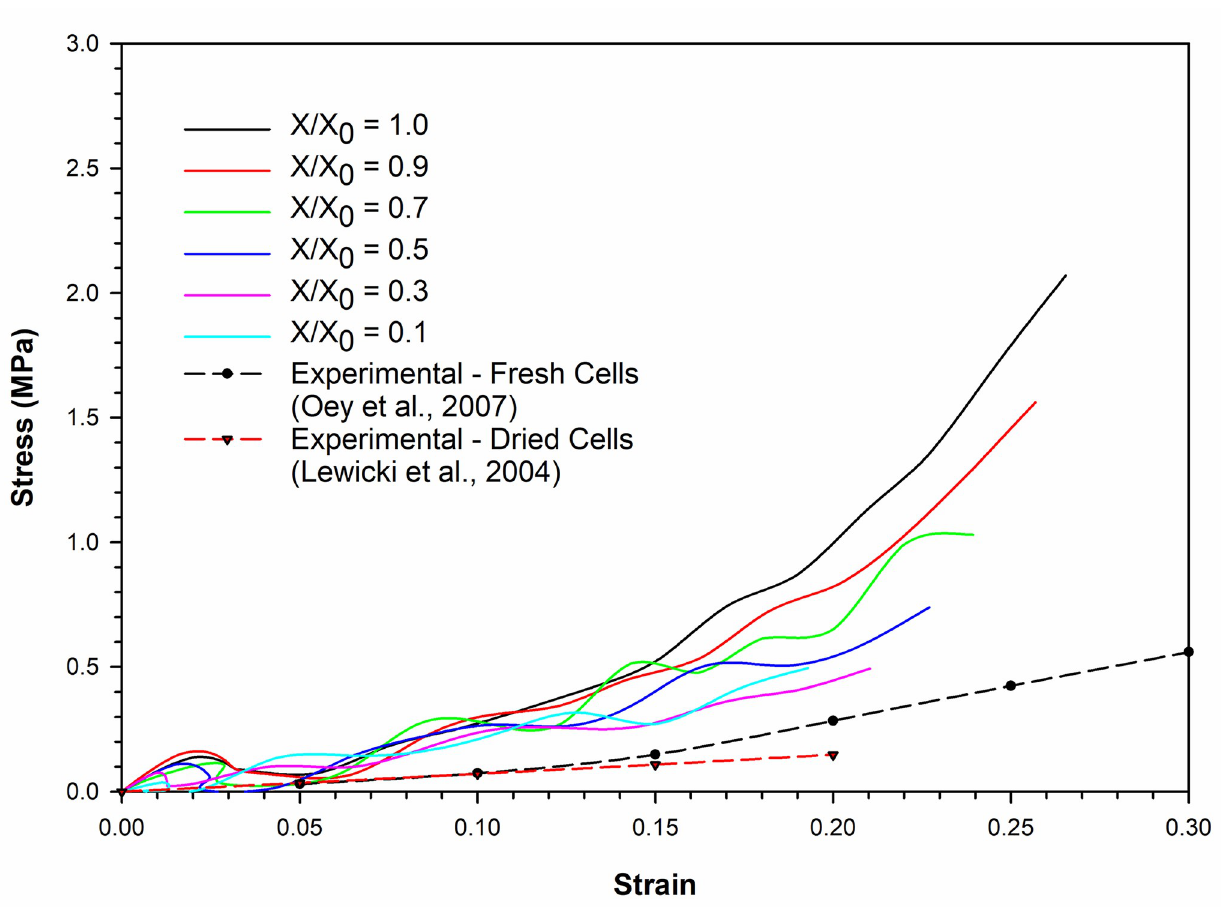
Fig 7. Comparison of model predictions for stress-strain relationship of the plant cell (at normal turgor pressure: 200 kPa) with corresponding experimental findings. [45, 46].